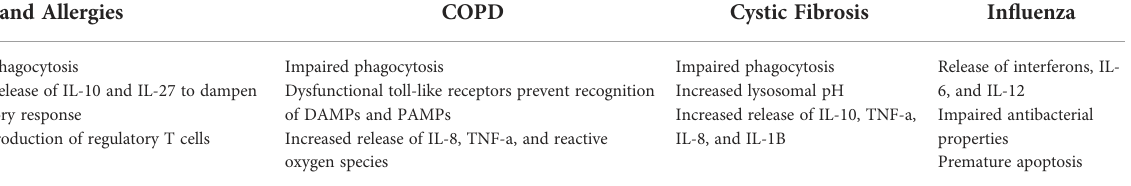
TABLE 5 Effects of disease on tissue-resident macrophages in the lung.